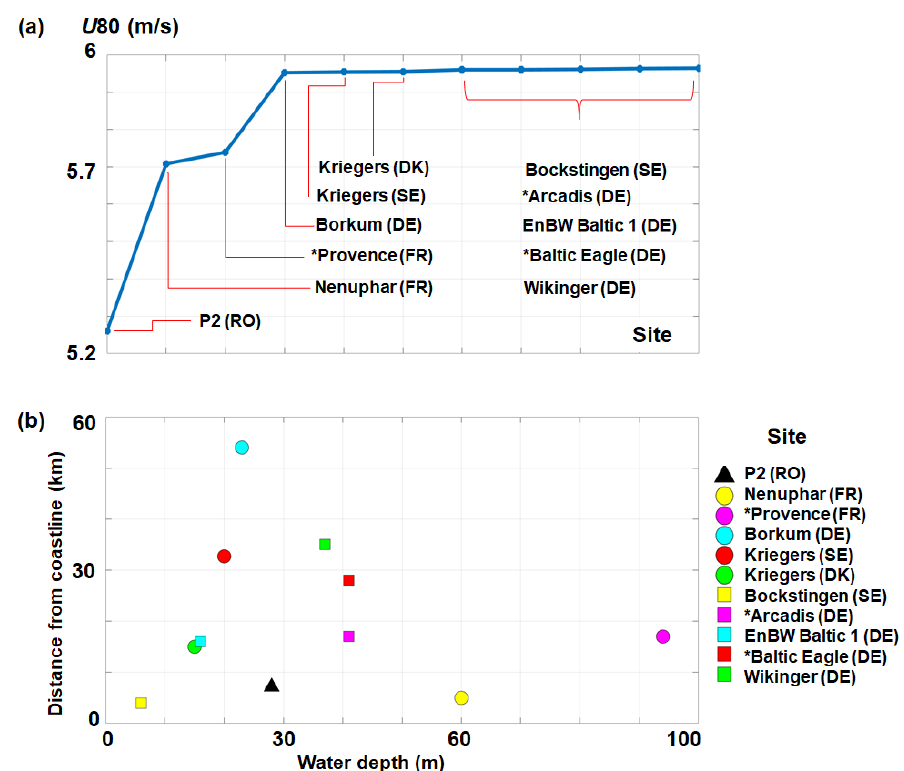
Figure 10. U 80 average values reported by the AVISO measurements (September 2009–September 2017).